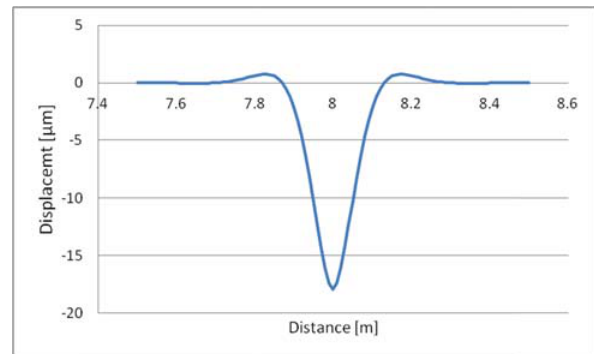
Figure 2: Di ff erence between rail head and whole rail vertical